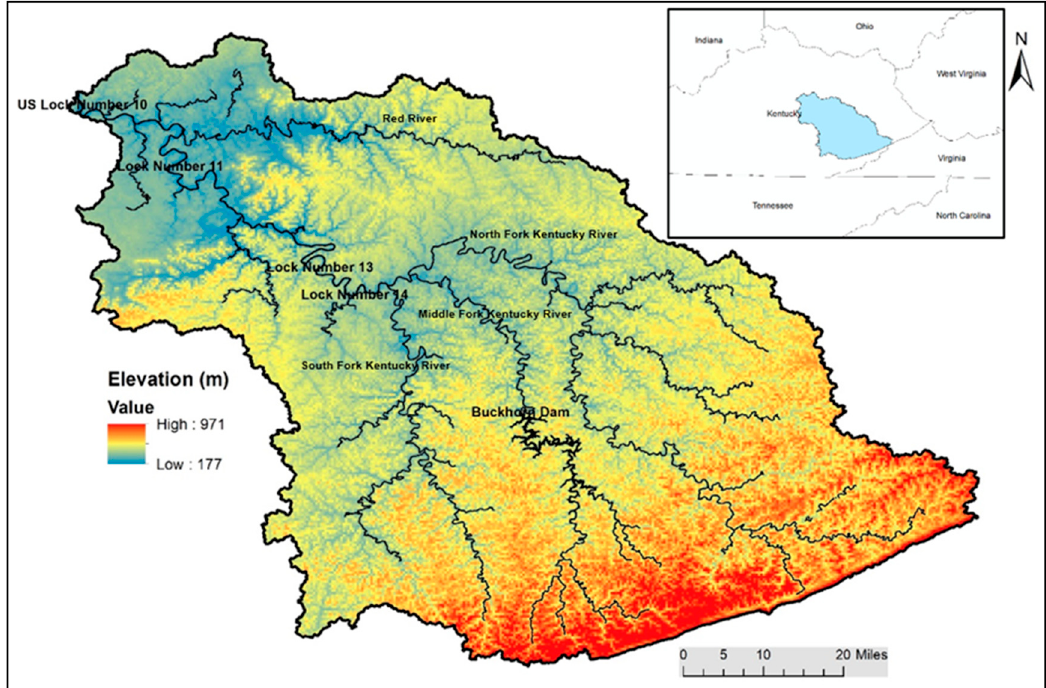
Figure 3. Digital Elevation Model of Upper Kentucky River Basin (Geographic Location of Upper Kentucky River Basin in the Inset).